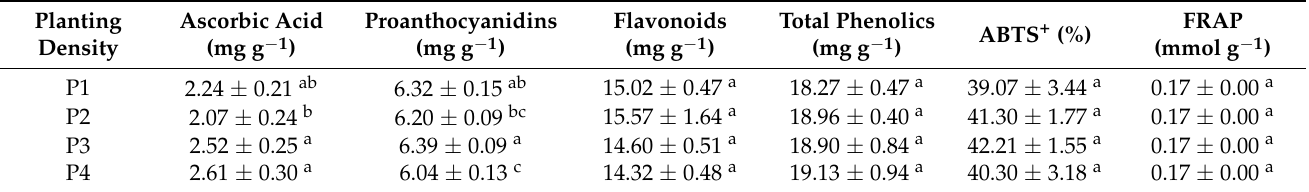
Table 4. Ascorbic acid, proanthocyanidins, flavonoids, total phenolics, and antioxidant activity content in different planting densities of mustard